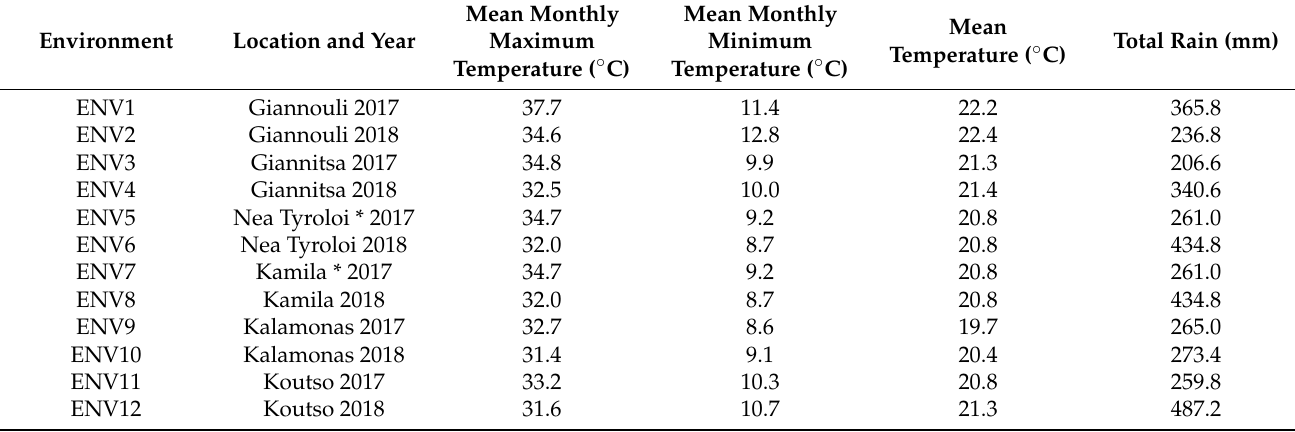
Table 2. Climatic conditions for the 12 examined environments during the cultivation period (March–September).